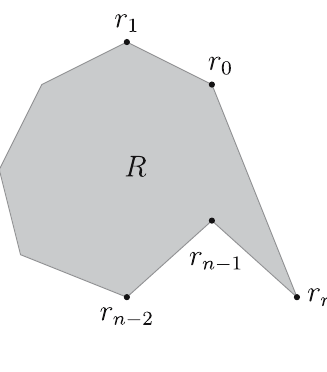
Figure 1: The ( ) κ CAT space R